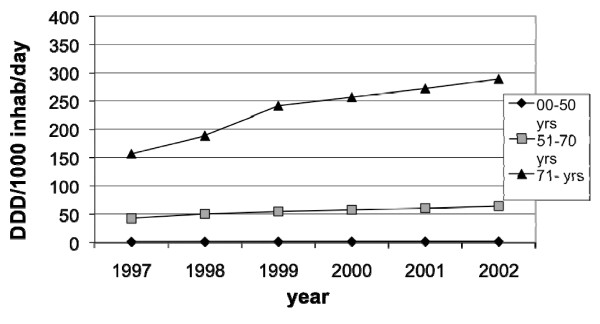
Sales of prescribed low-dose ASA between 1997–2002 in Sweden among females.